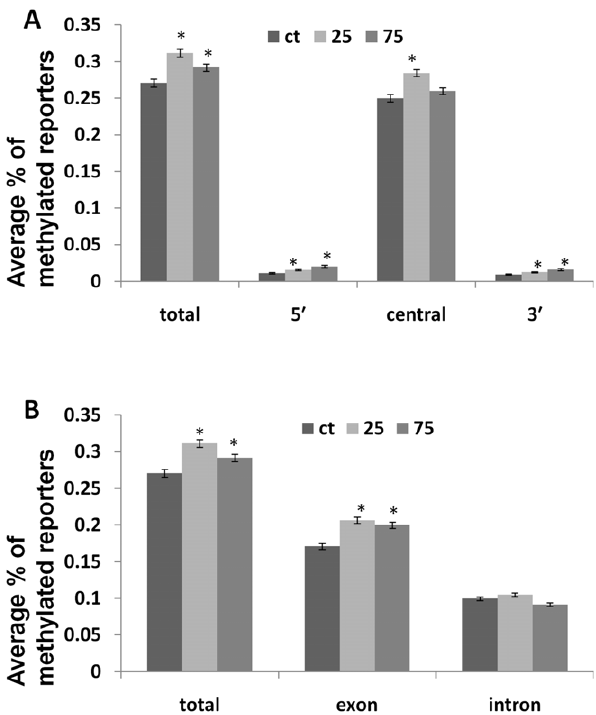
Figure 3. The average percentage of the differentially meth- ylated reporters located in various parts of the gene body. The figure shows the average percentage of methylated reporters (with SE, calculated for over 2,000 genes) found in the coding sequences of genes in the progeny of control plants (Ct) and the progeny of stressed plants (25 and 75 mM). The asterisks denote a significant difference between the progeny of plants exposed to 25 or 75 mM NaCl and the progeny of control plants (p , 0.05). A. The average percentage of methylated reporters in the entire coding sequence, in the 300 nts of the 5 9 end, in the 300 nts of the 3 9 end, and in the central part of the gene. B. The average percentage of methylated reporters in the entire coding sequence, in the exon and intron regions of the gene.